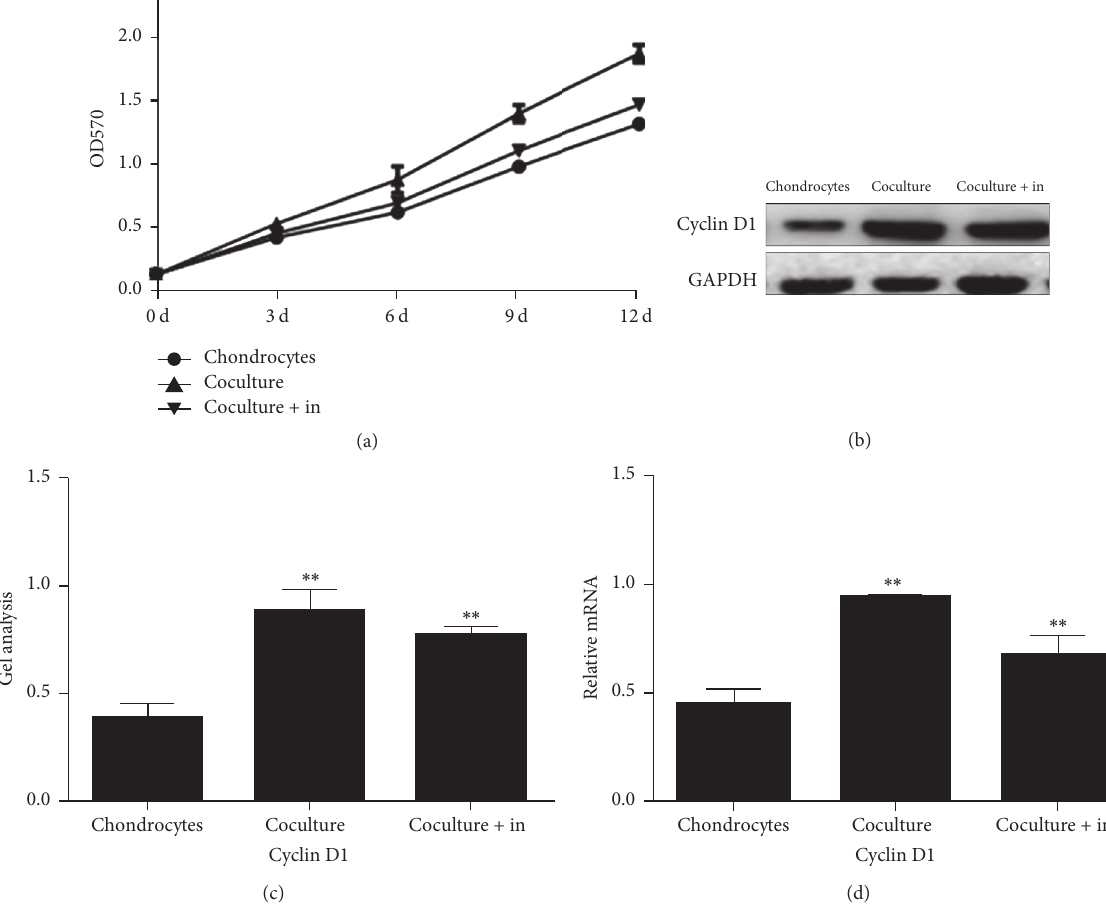
Figure 9: Effect of TGF- 𝛽 1 inhibitor on proliferation of chondrocytes cultured with different conditions for 5 days determined by MTT assay (a), western blot ((b), (c)), and real-time PCR (d). MMT assay indicated that chondrocytes grew much faster in ADSCs coculture system than control medium; however, when TGF- 𝛽 1 inhibitor was added to chondrocytes cocultured with ADSCs system, their proliferation was inhibited. Western blot and real-time PCR demonstrated that both gene expression and protein expression of Cyclin D1 were increased in chondrocyteswhichwereculturedwithADSCscoculturesystem,butCyclinD1wasnotashighinchondrocyteswhentheywereculturedwith TGF- 𝛽 1 inhibitor-containing ADSCs cocultured system ((b), (c), and (d)). Chondrocytes: chondrocytes were cultured in normal medium. Coculture: chondrocytes were cocultured with ADSCs. Cocultured + in: ADSCs cocultured system with TGF- 𝛽 1 inhibitor added. Data are shown as mean ± SEM. ∗∗ 𝑝 < 0.01 versus control